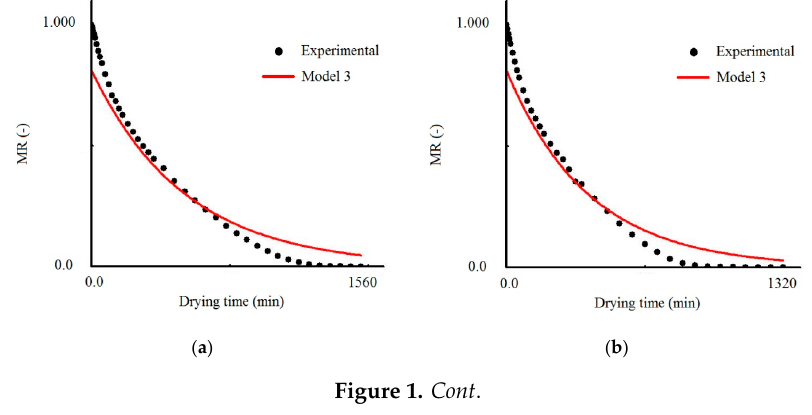
Table 1. Effective mass diffusivity for model